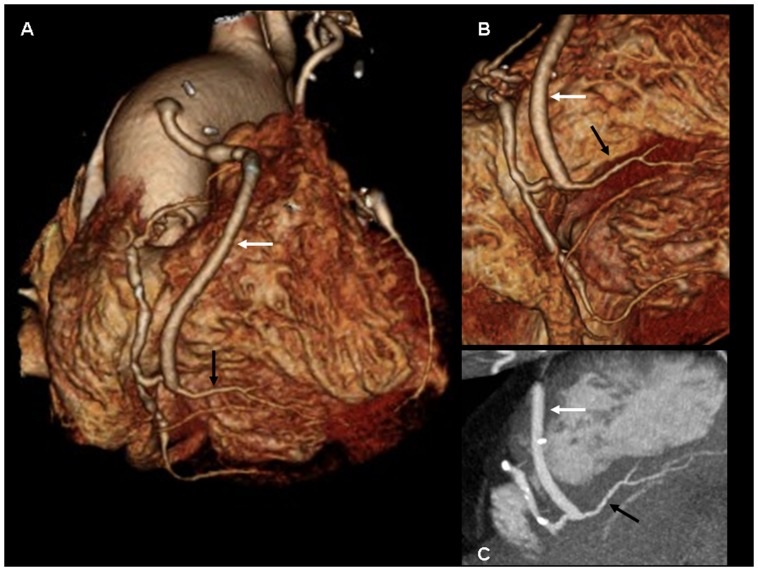
Coronary artery bypass graft – Terminolateral distal anastomosis.256-slice MDCT with prospective ECG-gating, volume rendering (A,B) and maximum intensity projection (C), of a 56-yo man with a aortocoronary saphenous vein graft (white arrow) to the posterior descending artery (PDA) (black arrow). An excellent opacification of a normal distal graft anastomosis on PDA can be seen.